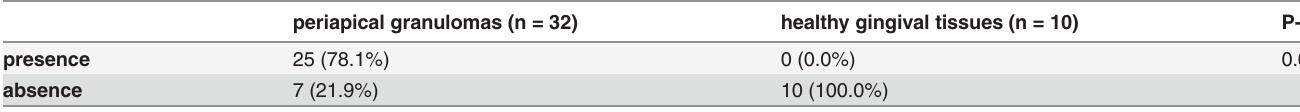
Table 1. Detection of EBV DNA using quantitative real-time